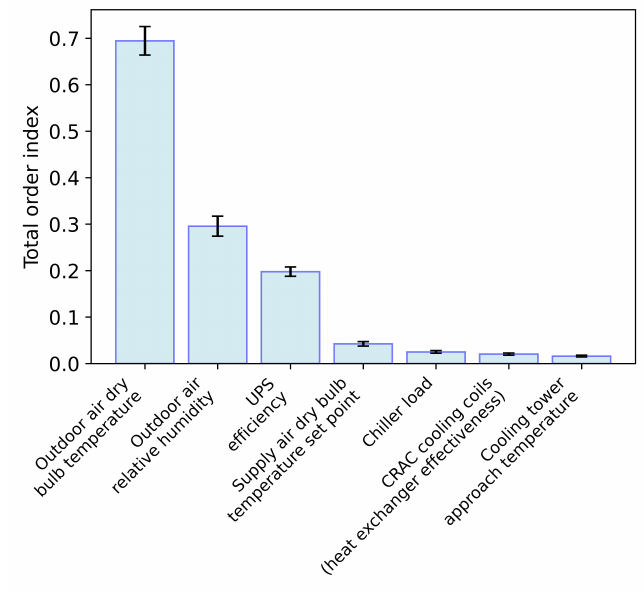
Figure 3. Total order sensitivity indices greater than 0.01.